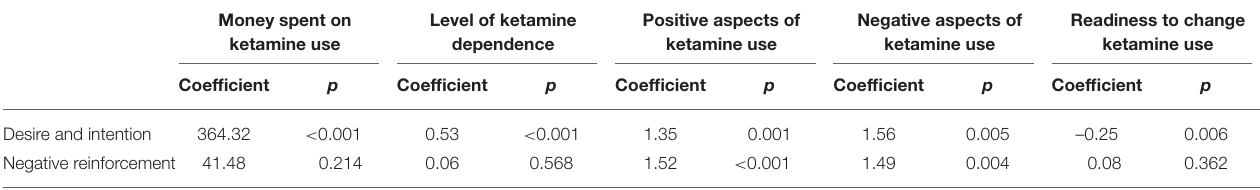
TABLE 3 | Associations of subscales of the DDQ-K with money spent on ketamine, severity of ketamine dependence, attitudes toward ketamine use, and readiness to accept treatment: multiple regression analysis a